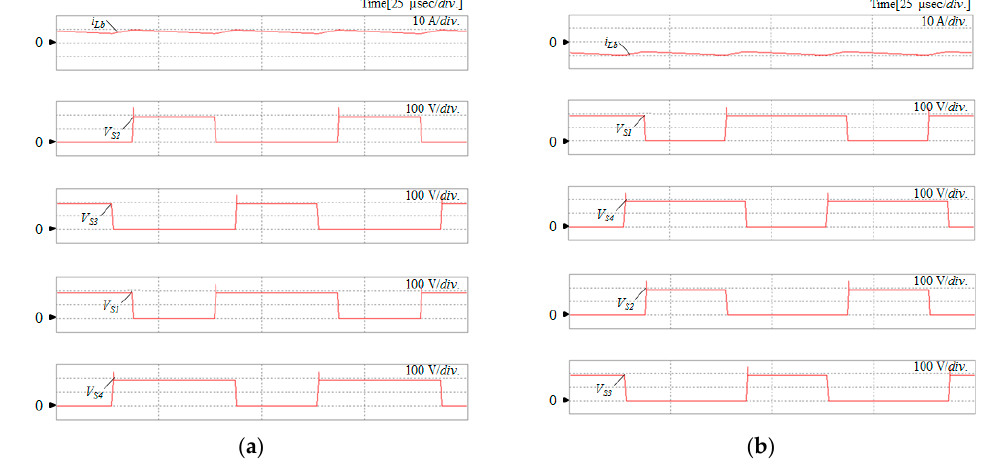
Figure 6. The simulation results of the conventional converter: ( a ) Step-up mode; ( b ) step-down mode.